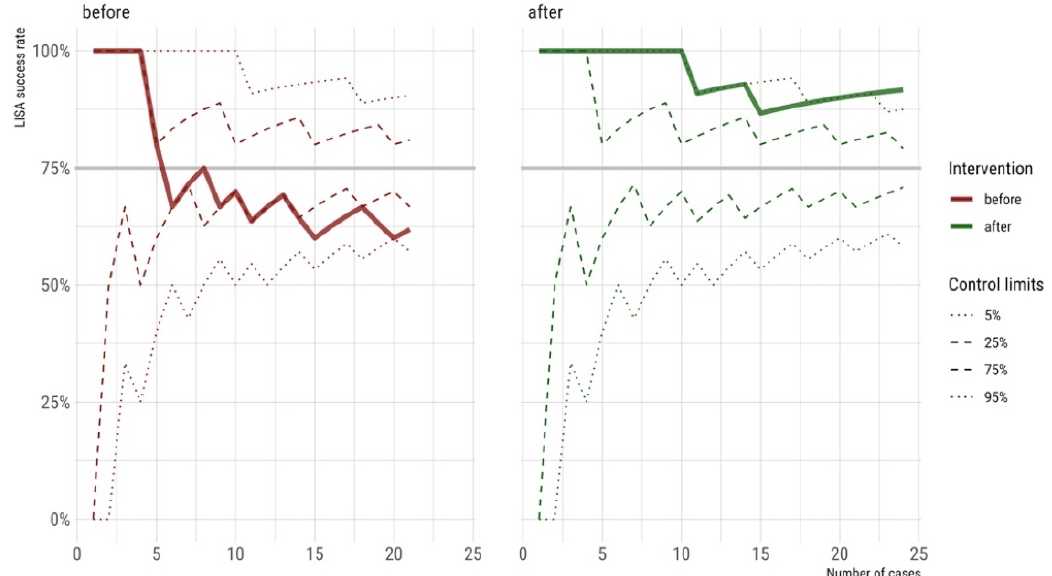
Figure 1. Process control chart: The less-invasive surfactant administration (LISA) success rates were calculated cumulatively with the respective 95% control limits using the Clopper-Pearson method. The light grey horizontal line indicates the target LISA success rate of 75%.